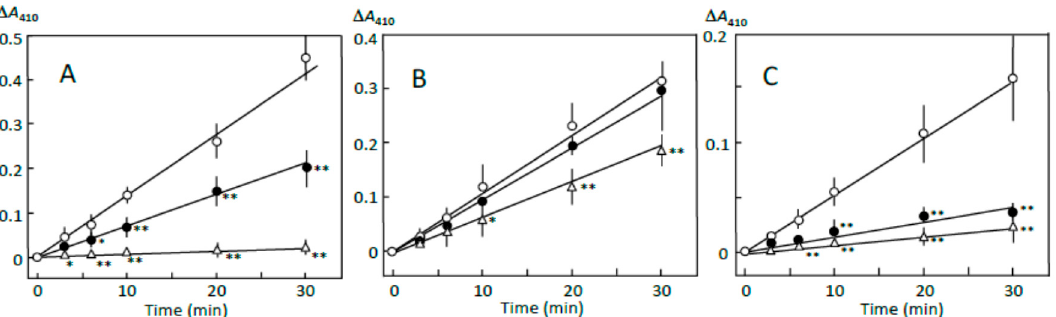
Figure 1. Adzuki extract-dependent inhibition of reducing sugar formation. The reaction mixture contained ( A ) retrograding joshinko, ( B ) the sediment, and ( C ) the supernatant in 0.1 M sodium phosphate (pH 7.0) with 0.15 M NaCl. Reactions were initiated by adding ( A ) and ( B ) 10 μ g mL − 1 or ( C ) 5 μ g mL − 1 of pancreatin. ( ○ ) no addition, ( ● ) 5 μ L, ( ∆ ) 10 μ L of the adzuki extract. Each data point is an average with SD ( n = 3). * p < 0.05; ** p < 0.01.